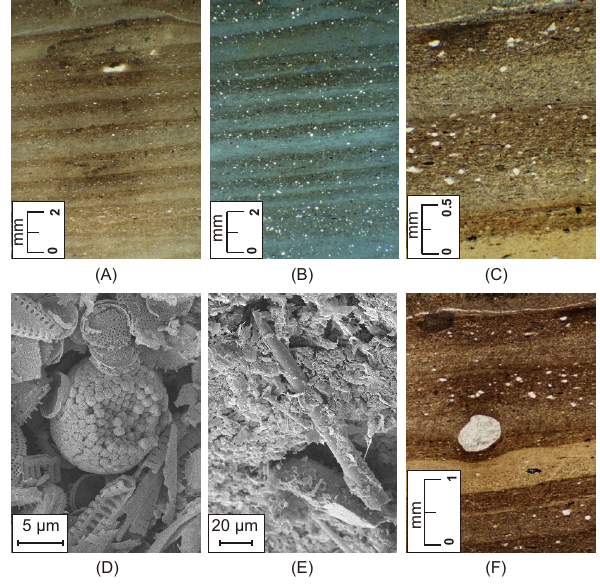
Fig. 2. Thin-section and scanning electron microscope pho- tographs of varves from the Dethlingen core: light and dark sub- layers (A) under parallel-polarized light and (B) under cross- polarized light; (C) close-up photograph of successive dark and light sub-layers; (D) pyrite framboids; (E) sponge spicule; (F) wind- transported fine sand